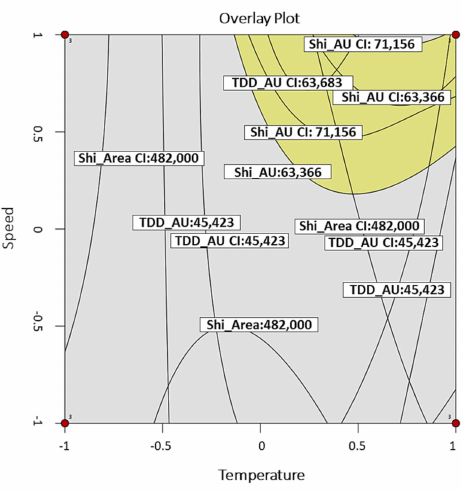
Figure 6. Contour plot with X3 (filter size) fixed at –1, 0, + 1 levels.